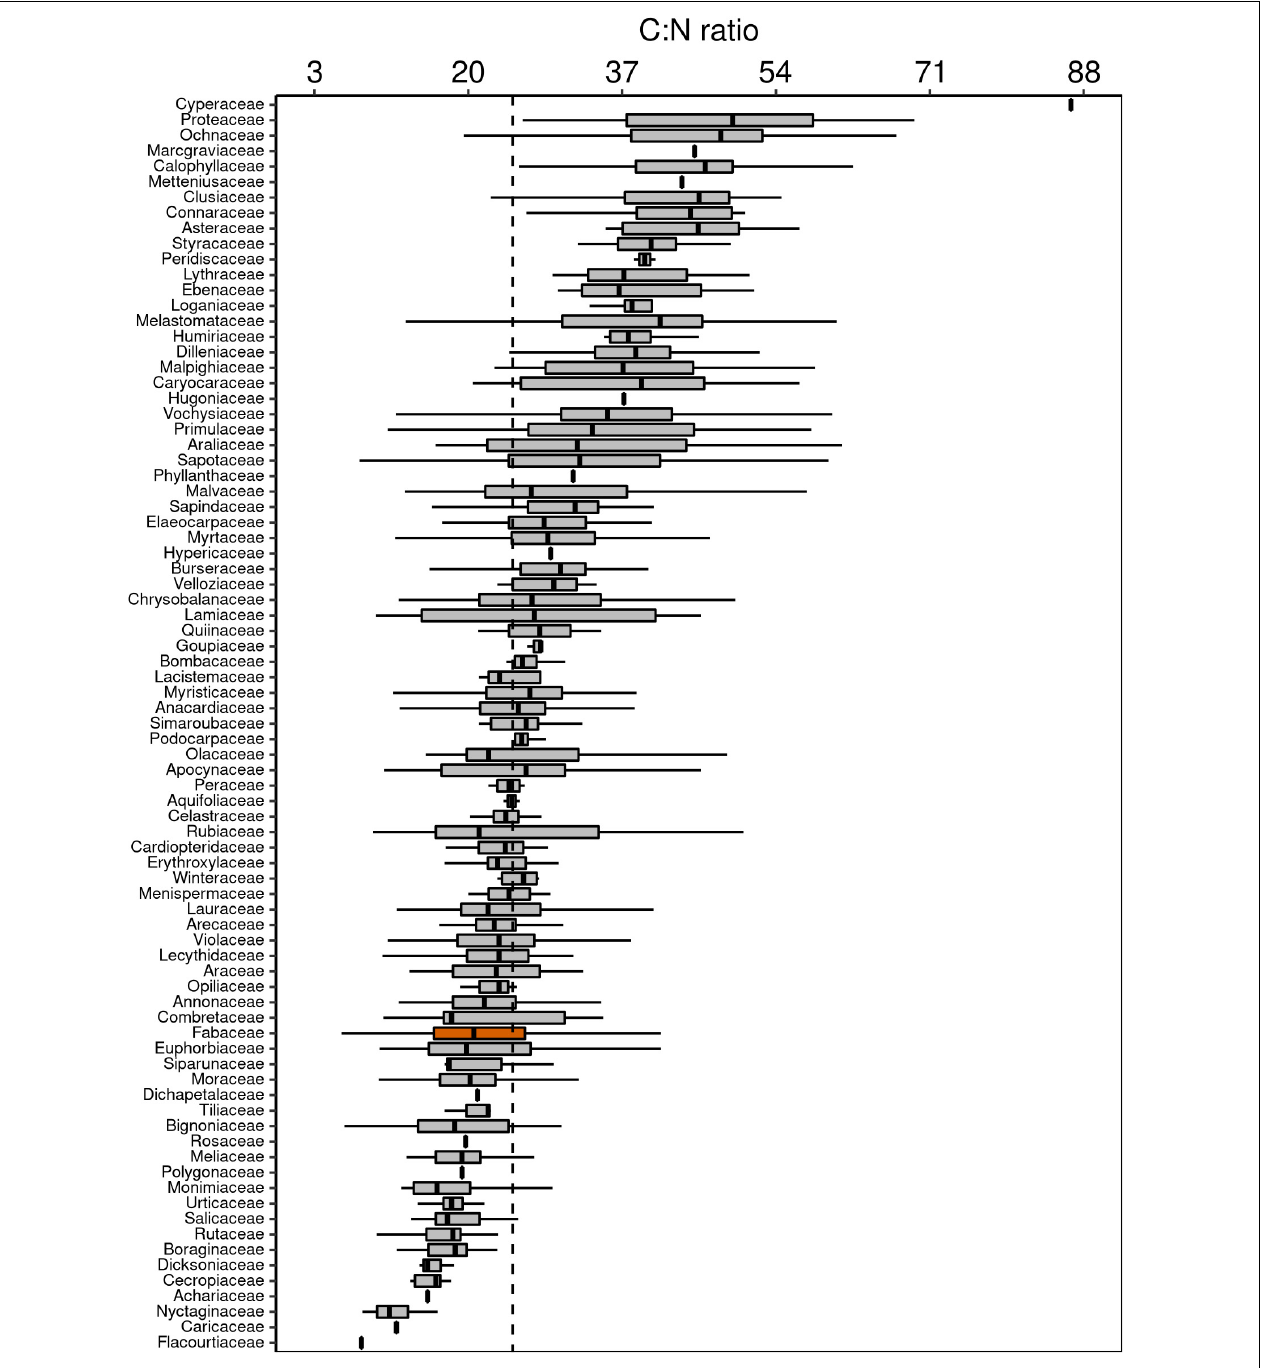
FIGURE 4 | Box-plots of foliar C:N ratio of botanical families in decreasing order. The vertical lines inside each box represent the median; the box represents the first and third quartiles; and the bars represent the interquartile range. The vertical dashed line represents the mean of the entire population. The orange box is evidencing the Fabaceae family, where a notable part of the species is capable of fixing atmospheric N through symbiotic associations.